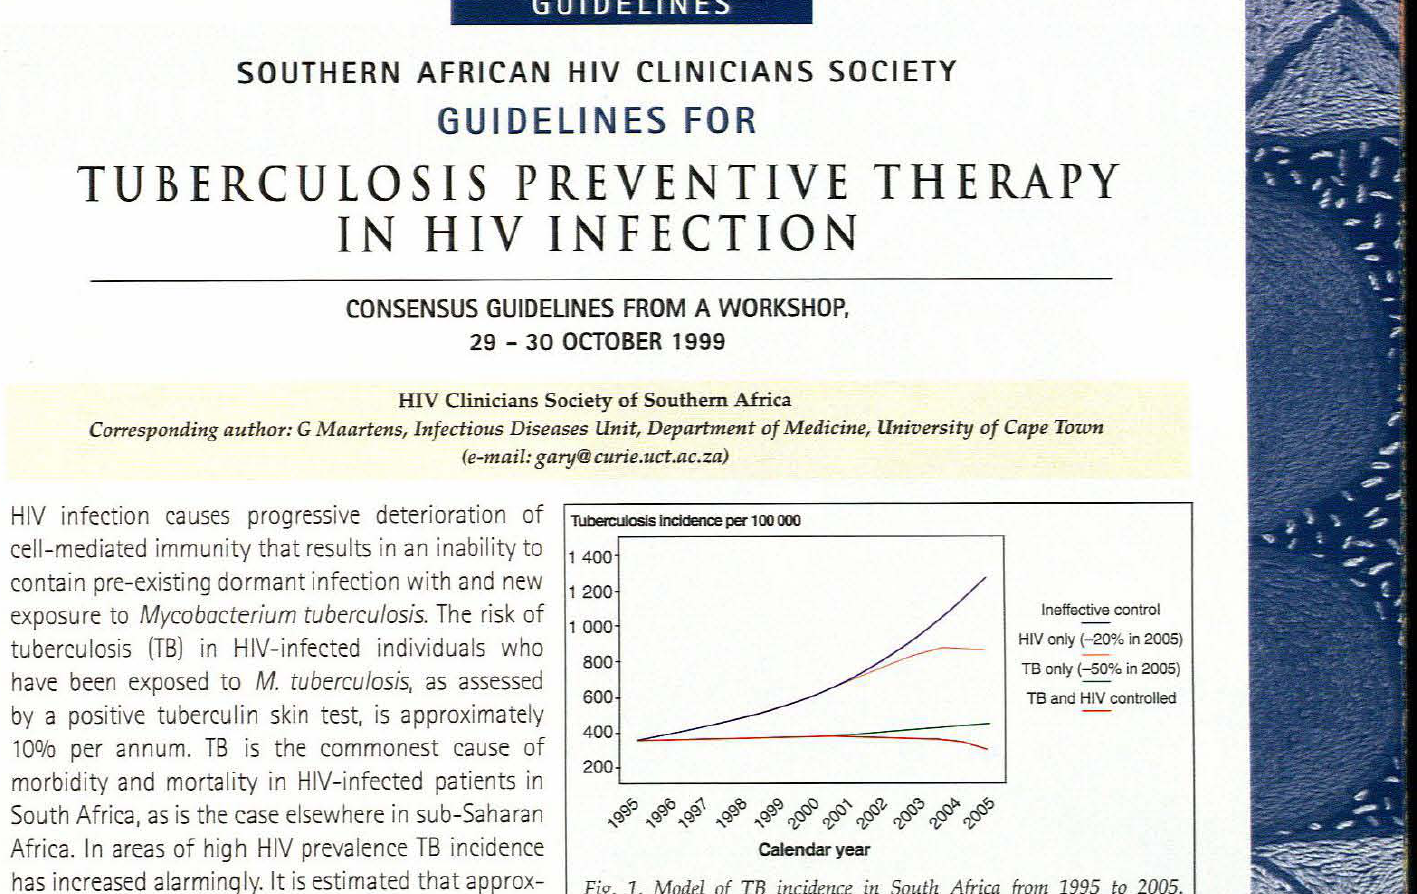
Fig. 1. Model of TB incidence in South Africa from 1995 to